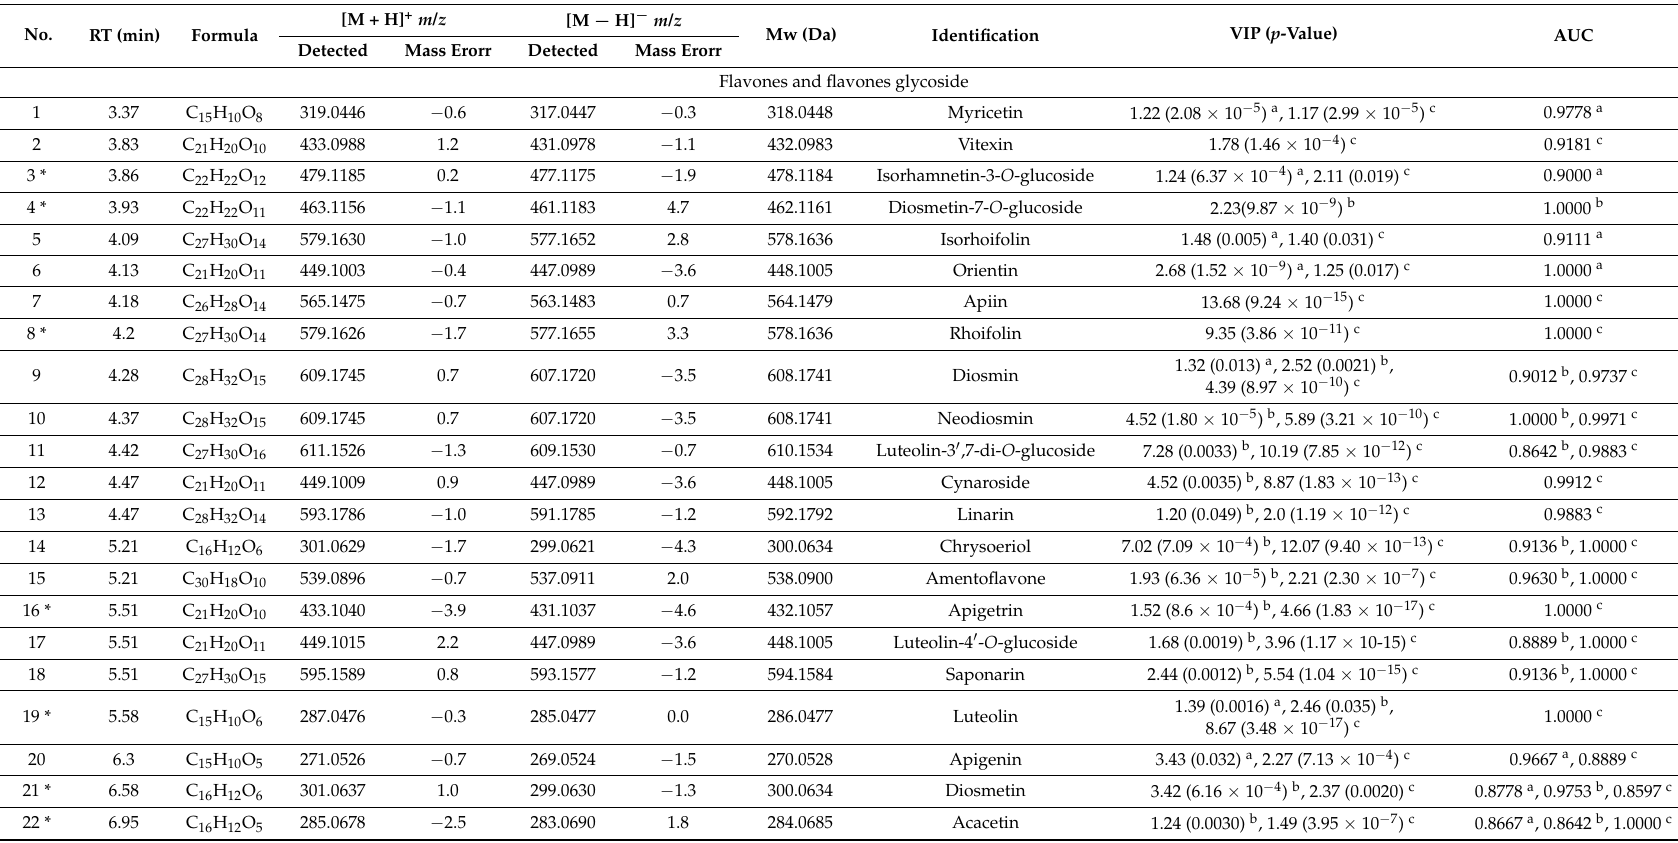
Table 2. Differential secondary metabolites between Chenpi (CP)/Qingpi (QP), Zhiqiao (ZQ)/Zhishi (ZS) and Citrus aurantium L. (CA)/ Citrus reticulate Blanco. (CR) group profiles in positive and negative ion